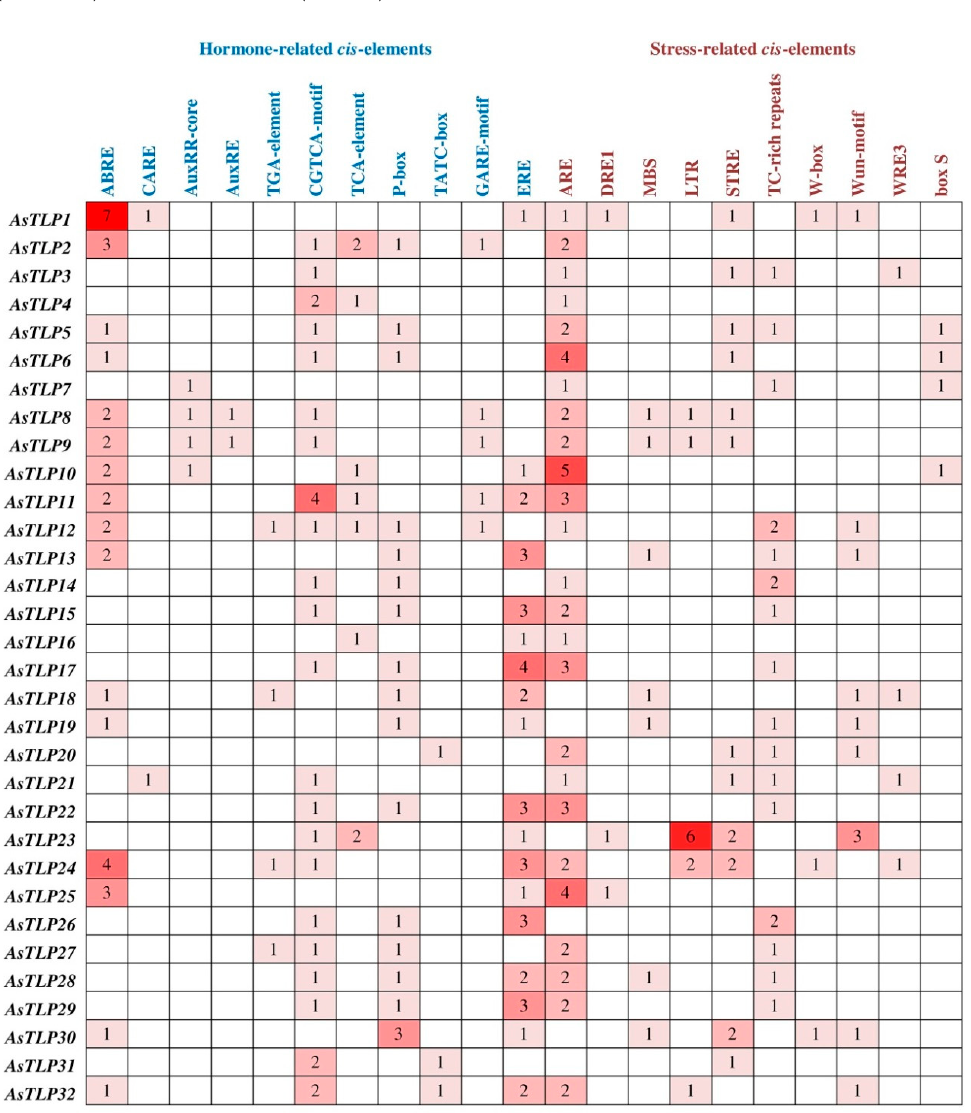
Figure 5. Hormone ˗ and stress ˗ responsive cis ˗ elements in the regulatory regions (~1000 bp) of Figure 5. Hormone- and stress-responsive cis -elements in the regulatory regions (~1000 bp) of AsTLP AsTLP genes. The color scheme (from pale to dark) corresponds to the numbers of cis ˗ elements genes. The color scheme (from pale to dark) corresponds to the numbers of cis -elements (from low (from low to high). to